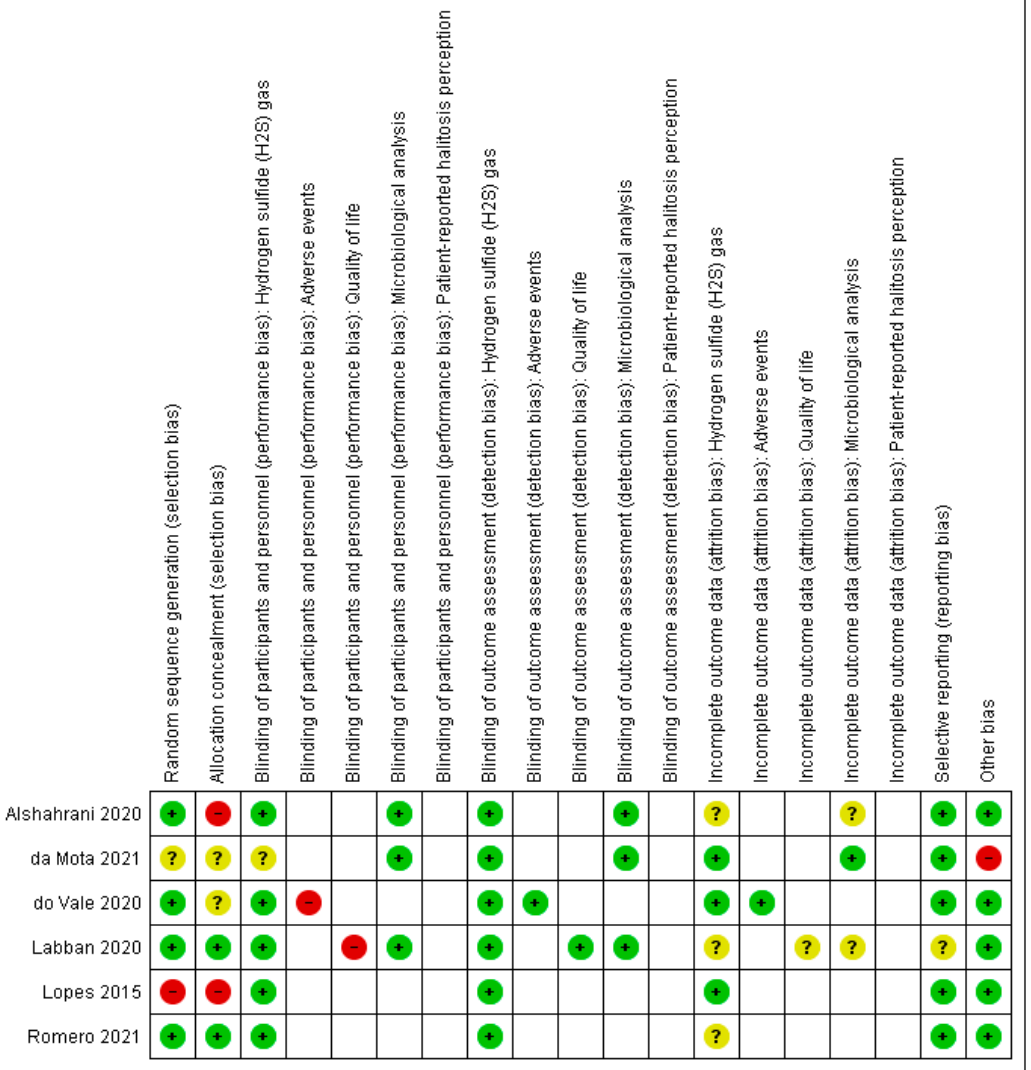
Figure 2. Risk of bias summary: review authors’ judgments about each risk of bias item for each included study.